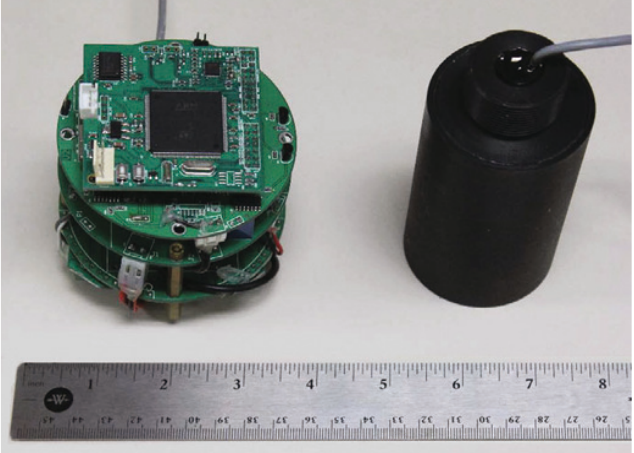
Figure 4. The UWA communication